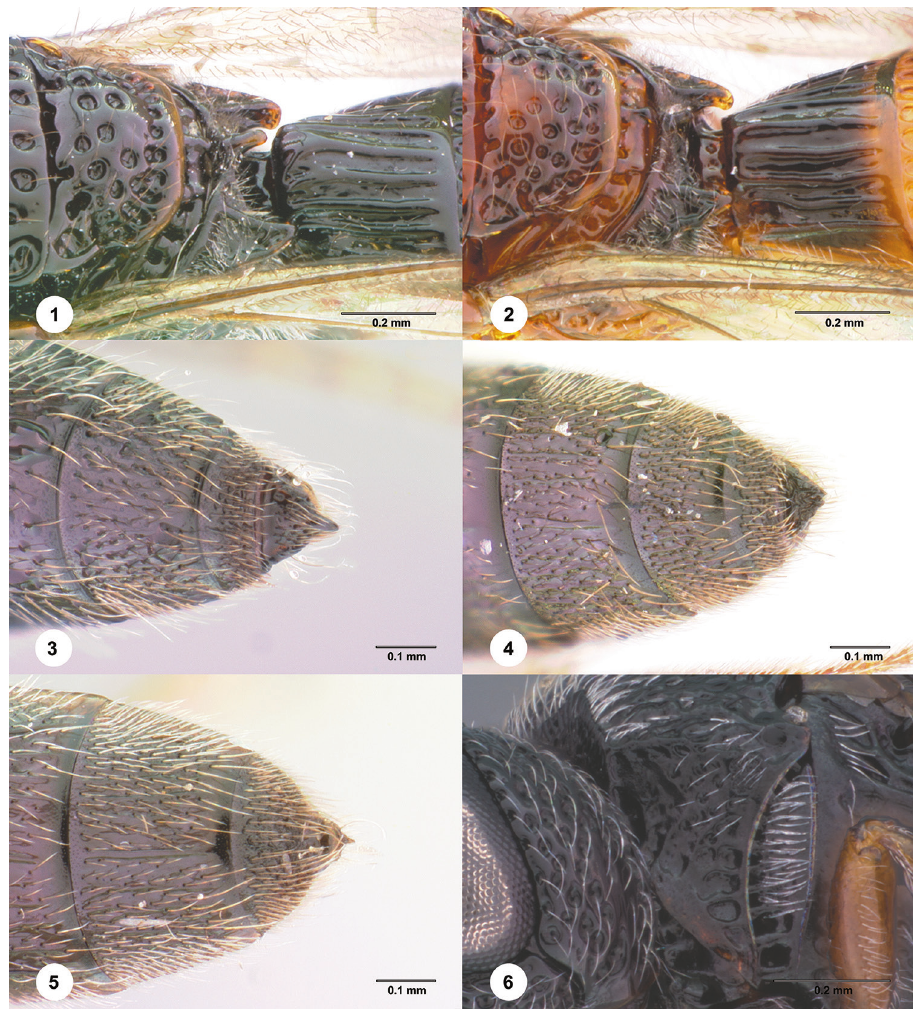
Figures 1–6. 1–2 Habroteleia mutabilis sp. n. 1 Paratype (FBA 143219), Propodeum, dorsolateral view 2 Holotype (FBA 070892), Propodeum, dorsolateral view 3 Habroteleia salebra sp. n., male, paratype (OSUC 688063), Apex of metasoma, dorsal view 4 Habroteleia spinosa sp. n., male, paratype (OSUC 232878), Apex of metasoma, dorsal view 5 Habroteleia spinosa sp. n., female, holotype (OSUC 232889), Apex of metasoma, dorsal view 6 Habroteleia flavipes , male (OSUC 58007), Pronotum, lateral view. rugose, with a medial furrow and smooth areas laterally. Sculpture of lateral lobe of mesoscutum: sparsely punctate. Sculpture of lateral propodeal area: rugose. Setation of mesoscutellum: dense. Sculpture of mesoscutellum: coarsely punctate rugose. Median propodeal projection: short. Mesopleural carina: distinct. Sculpture of mesepisternum anteroventral to mesopleural depression: punctate rugose. Sculpture of dorsal meta- pleural area: smooth to rugulose. Sculpture of ventral metapleural area: punctate